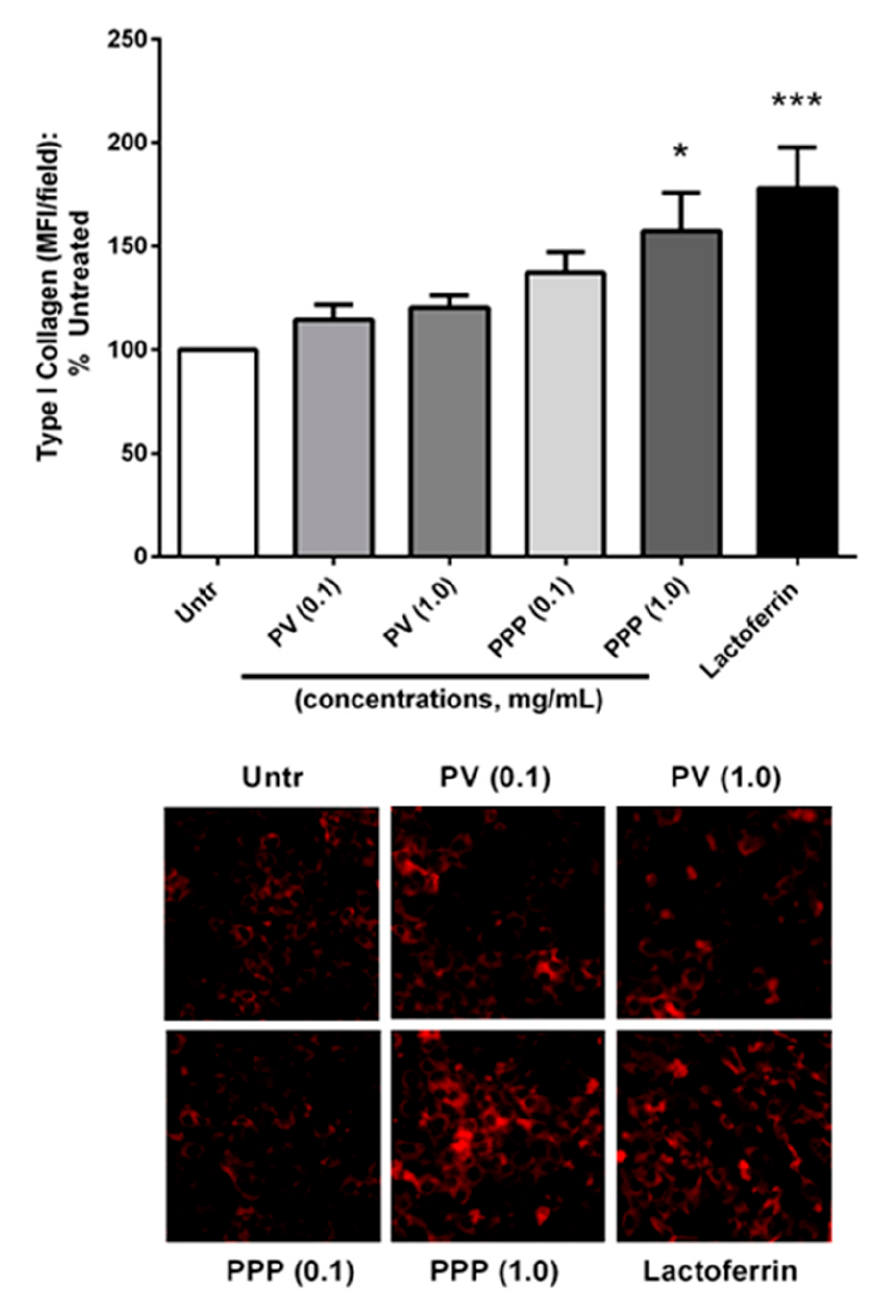
Figure 4. PPP but not phosvitin increase type I collagen levels in osteoblastic cells. Confluent monolayers of MC3T3-E1 cells were treated for 72 h with di ff erent concentrations (0.1 and 1.0 mg / mL) of phosvitin (PV) or PPP prior to being fixed, permeabilized and immunostained for type I collagen. Mean fluorescence intensity was measured as the average of total fluorescent intensity from 3 randomly selected fields per group and expressed as a percentage of the untreated control. Data are mean ± SEM from 5–6 independent experiments. * and *** indicate p < 0.05 and p < 0.001 respectively, as compared to the untreated control group.